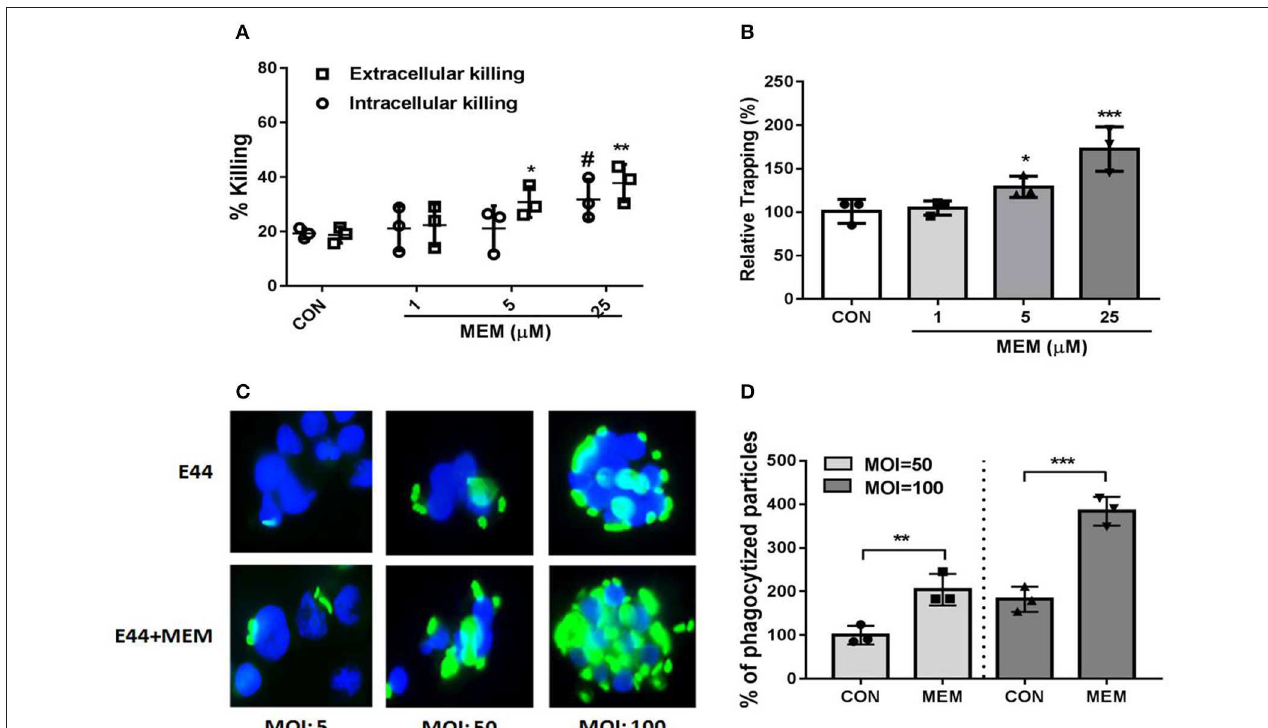
FIGURE 2 | MEM enhanced bacterial killing by neutrophils. (A) Intracellular and extracellular killing of E. coli E44 after treatment with MEM. Neutrophil killing of bacteria includes two parts: intracellular killing and extracellular killing. A intracellular killing inhibitor of Cytochalasin D was used to distinguish intracellular killing of PMNs and extracellular killing microbes; (B) NETs trapping promoted by MEM. Neutrophils were stimulated for NET formation and infected with E44 at an MOI of 50. Different concentration of MEM was incubated with the neutrophils. Viable bacteria were quantified by plating of serial dilutions. The percentage of CFU trapped